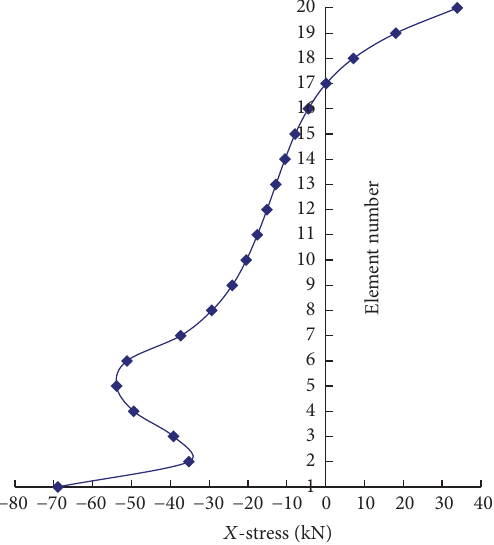
Figure 8: Distribution of earth pressure.